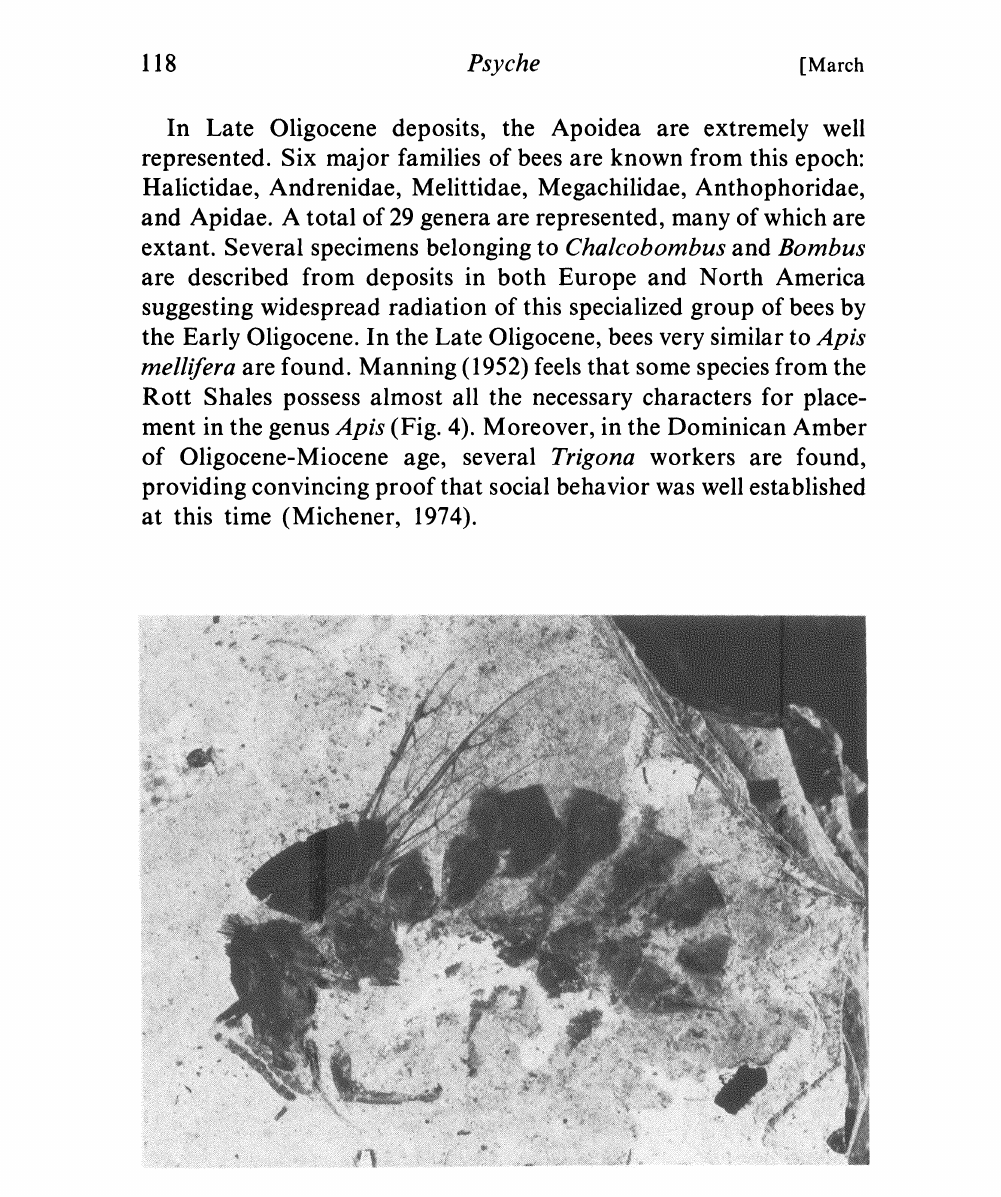
Figure 4. Apis henshawi Cockerell from Upper Oligocene of Rott, Germany. Original photograph of holotype in Museum of Comparative Zoology. Length of body, 15